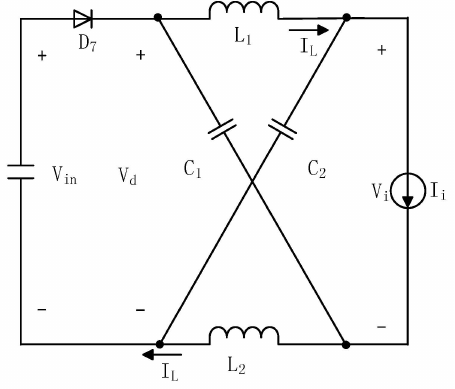
Figure 2. Equivalent circuit of the Z-source inverter (ZSI) in the non-shoot-through zero state.